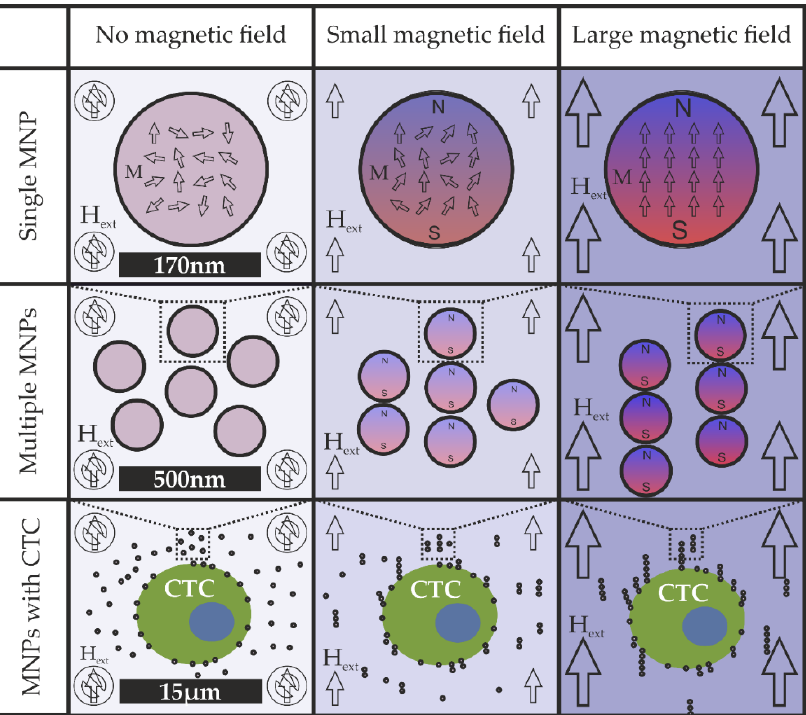
Figure 2. Graphical depiction of the magnetization of a magnetic nanoparticle (MNP) in an increasing external field. Top panel, alignment of magnetic domains in the magnetic particles. Middle panel, alignment of magnetic particles. Bottom panel, alignment of magnetic particles in the presence of a